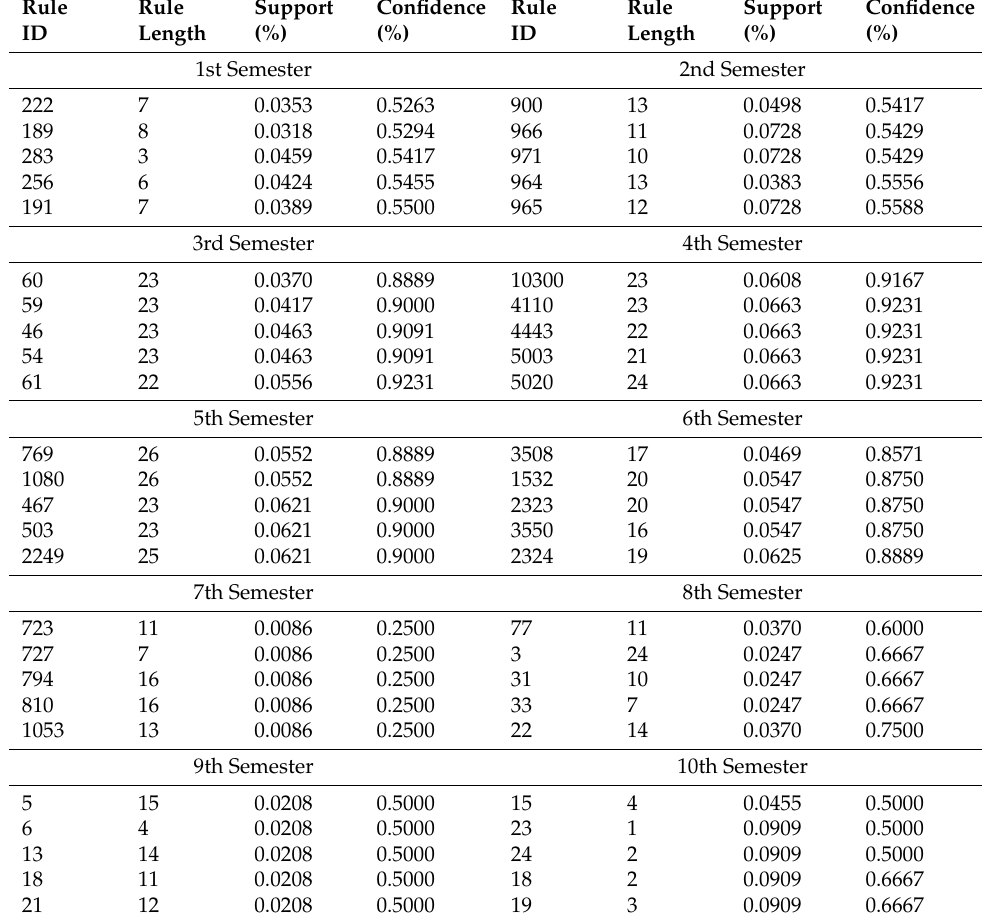
Table 3. The critical dropout rules of given semesters. It shows the pattern of uncompleted subjects which should definitely be avoided by active students.